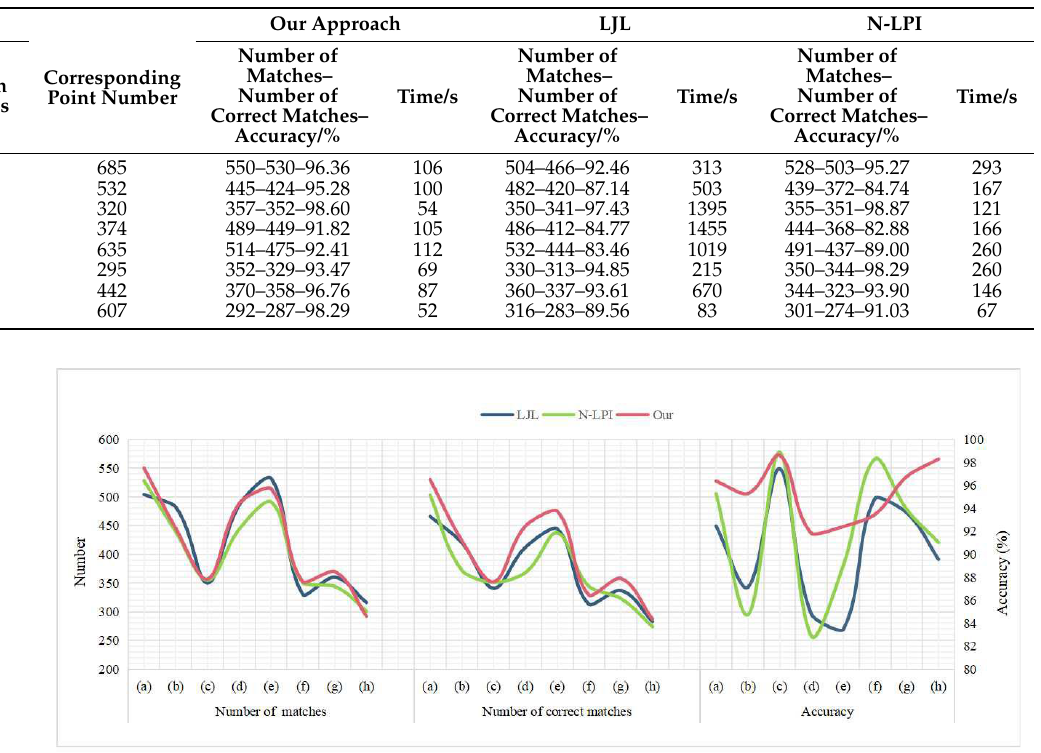
Table 1. Comparison of proposed approach and two state-of-the-art line matching approaches (LJL and N-LPI) for 8 image pairs.